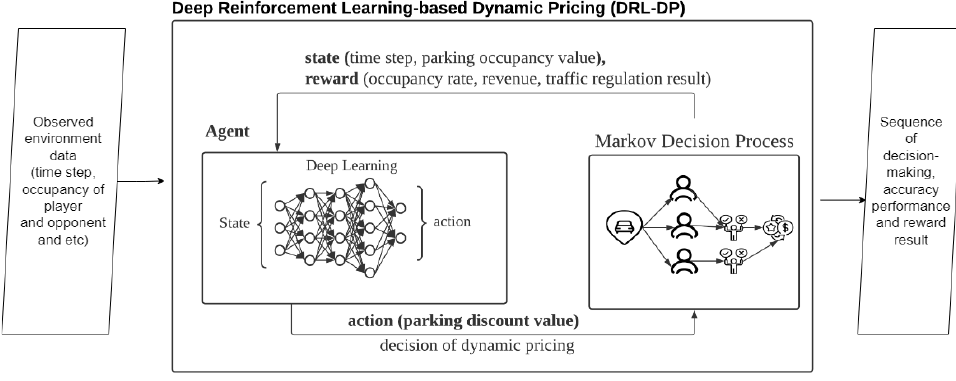
Figure 1. Block diagram of the proposed